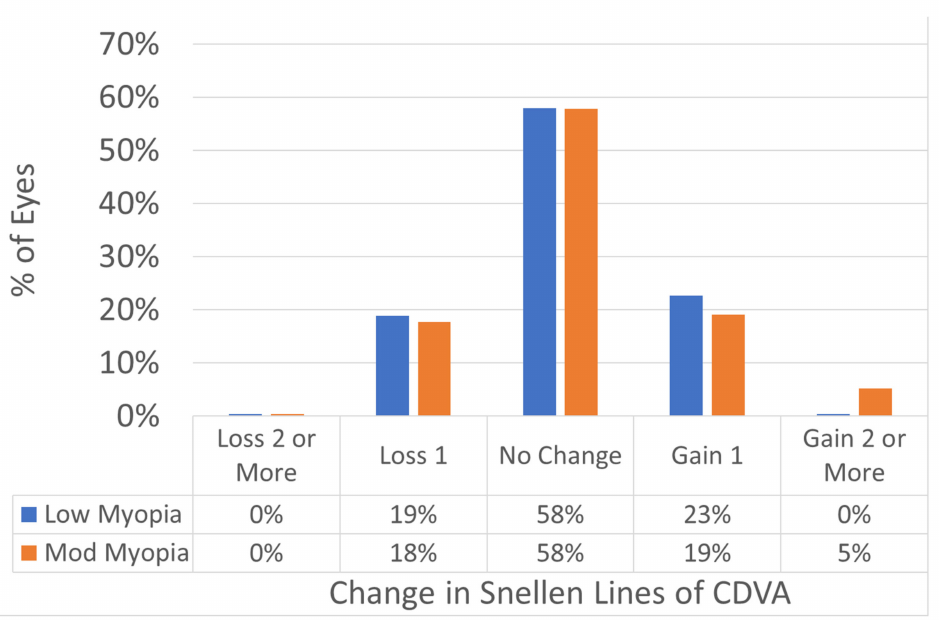
Figure 3. Safety change for CDVA preoperatively versus postoperatively in Snellen lines. The change in CDVA from preop to postop was 0.0 ± SD 0.7 lines in the low myopia group, and +0.1 ± SD 0.8 lines gain in the moderate myopia group ( p = 0.1). No eye lost 2 or more lines of CDVA in either